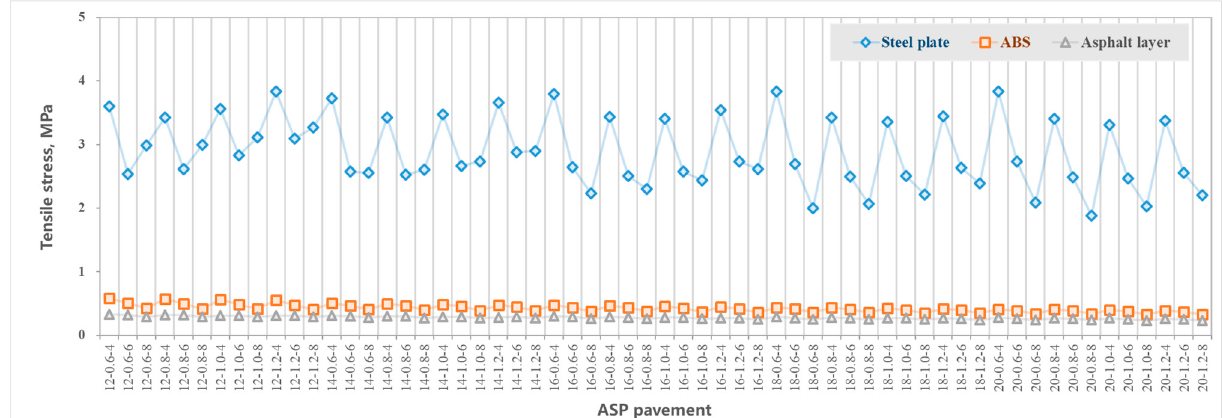
Figure 6. Compressive (vertical) strain at the top of subgrade (note: compressive (vertical) strain is negative).